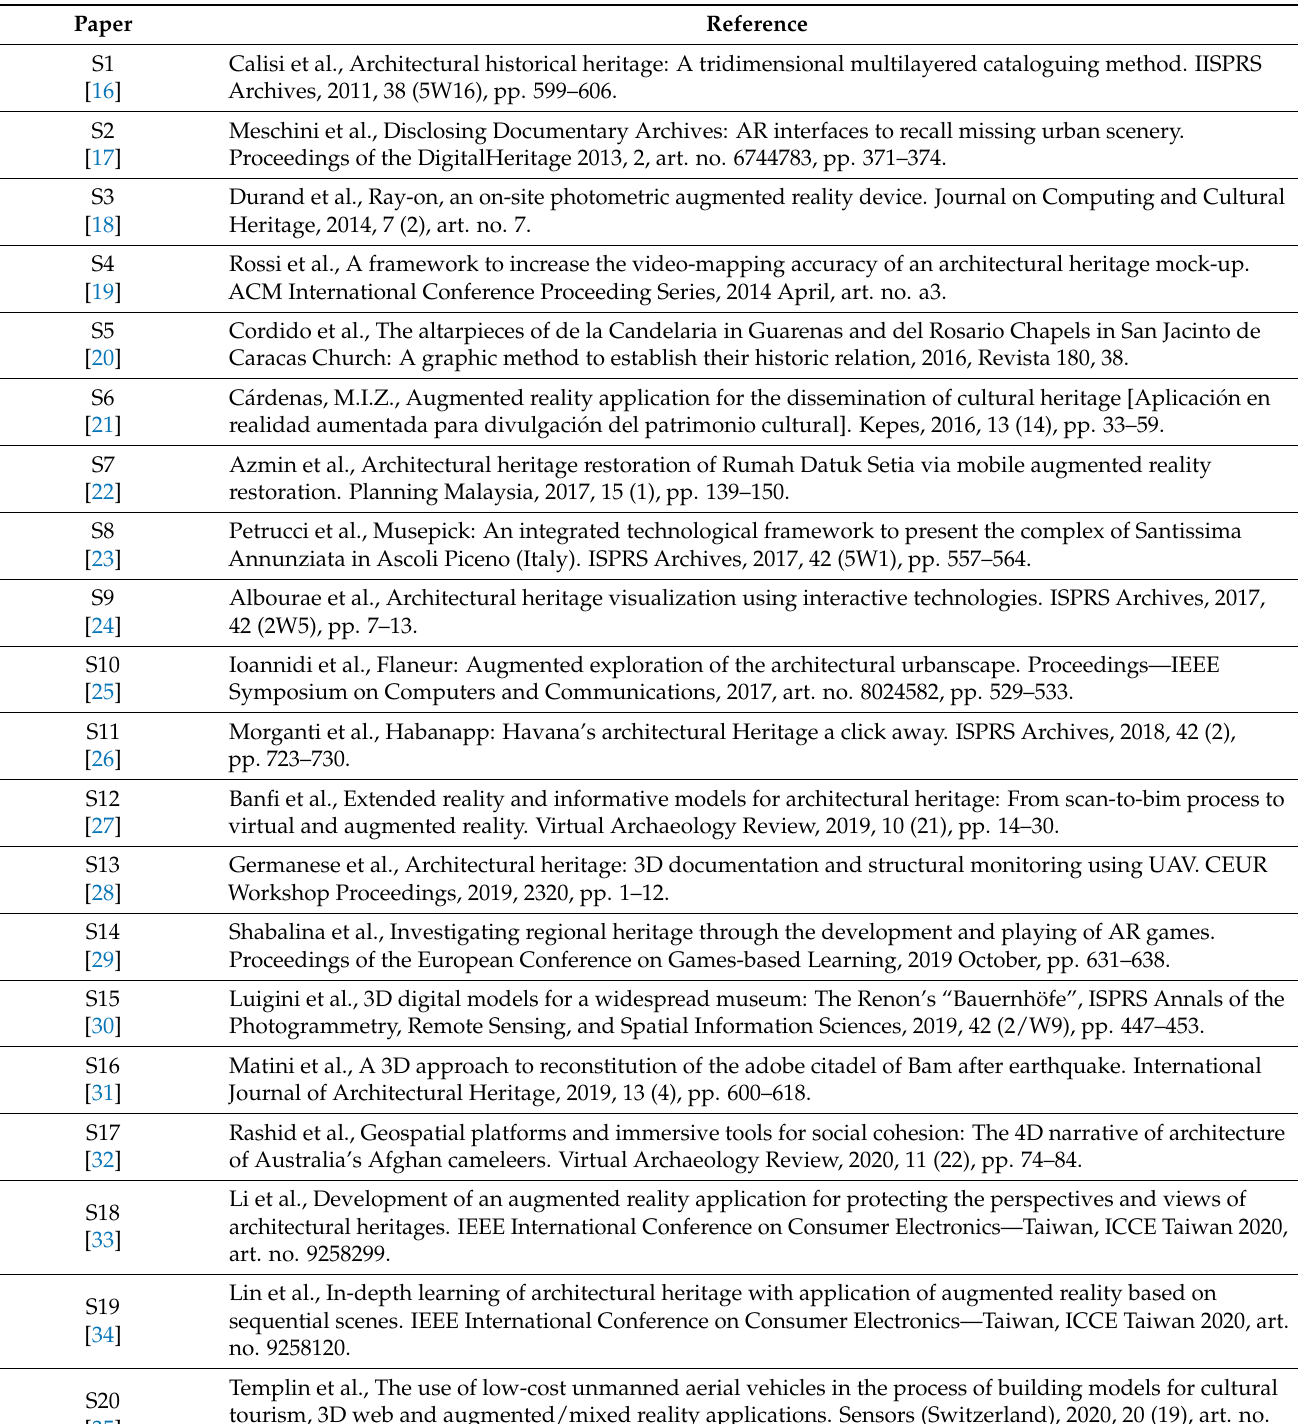
Table 2. Documents selected from the query “augmented reality” and “architectural